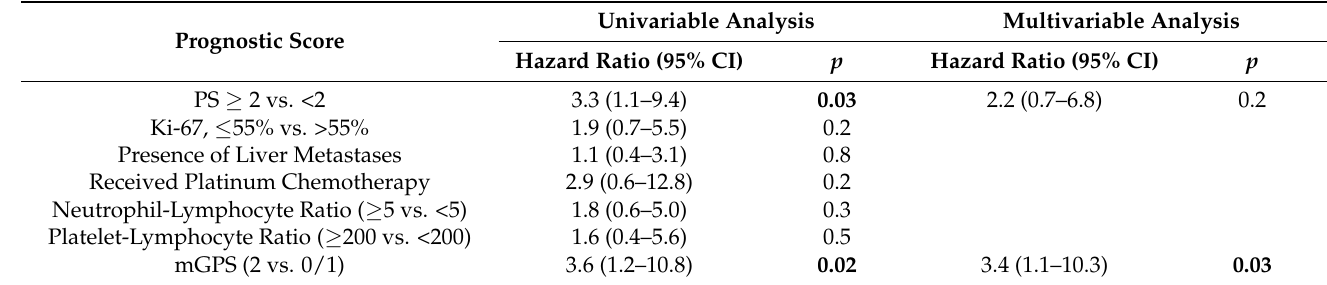
Table 4. Univariable and multivariable analysis for overall survival in G3-NETs.